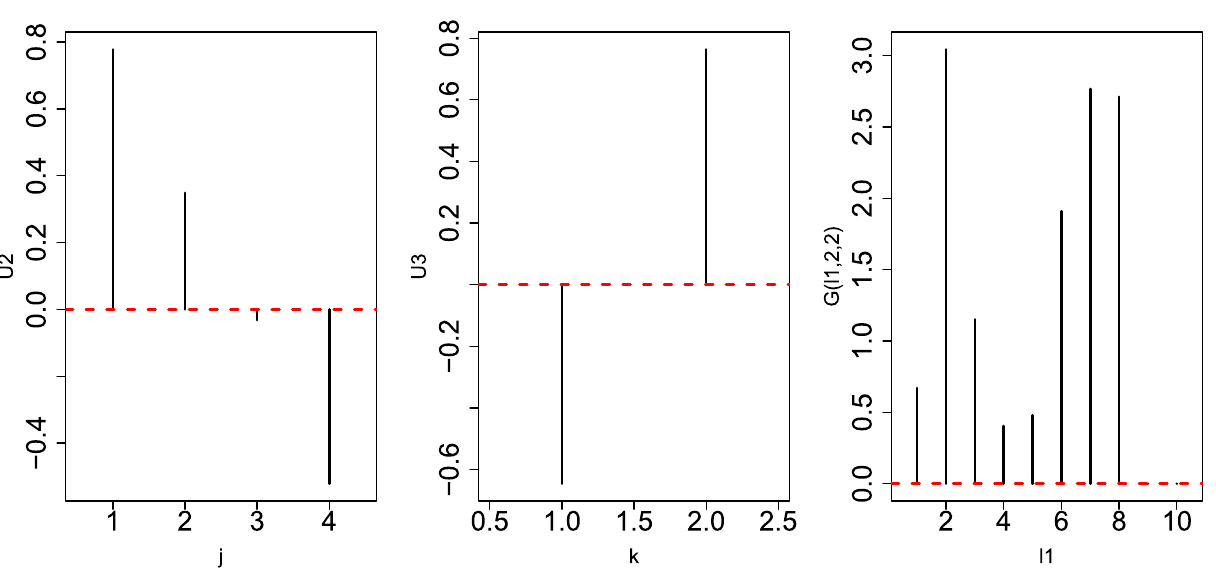
Figure 5. Left: Singular value vector, u 2 j , computed by HOSVD applied to the 1st synthetic data, x ijk . Middle: Singular value vector, u 1 k , computed by HOSVD applied to 1st synthetic data, x ijk . Right: | G (ℓ 1 , 2, 1 ) | . In all three sub-panels, the horizontal red broken lines indicate the baseline (zero).